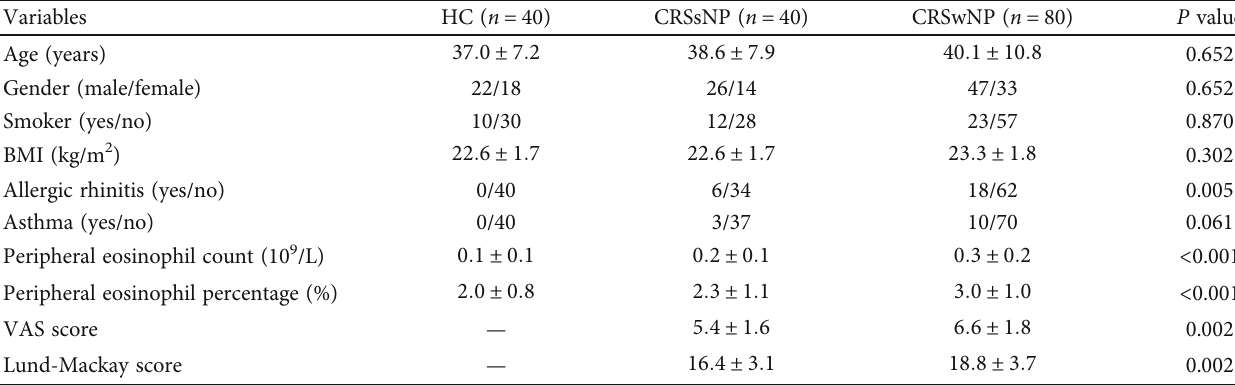
Table 1: The demographic and clinical characteristics among three groups.